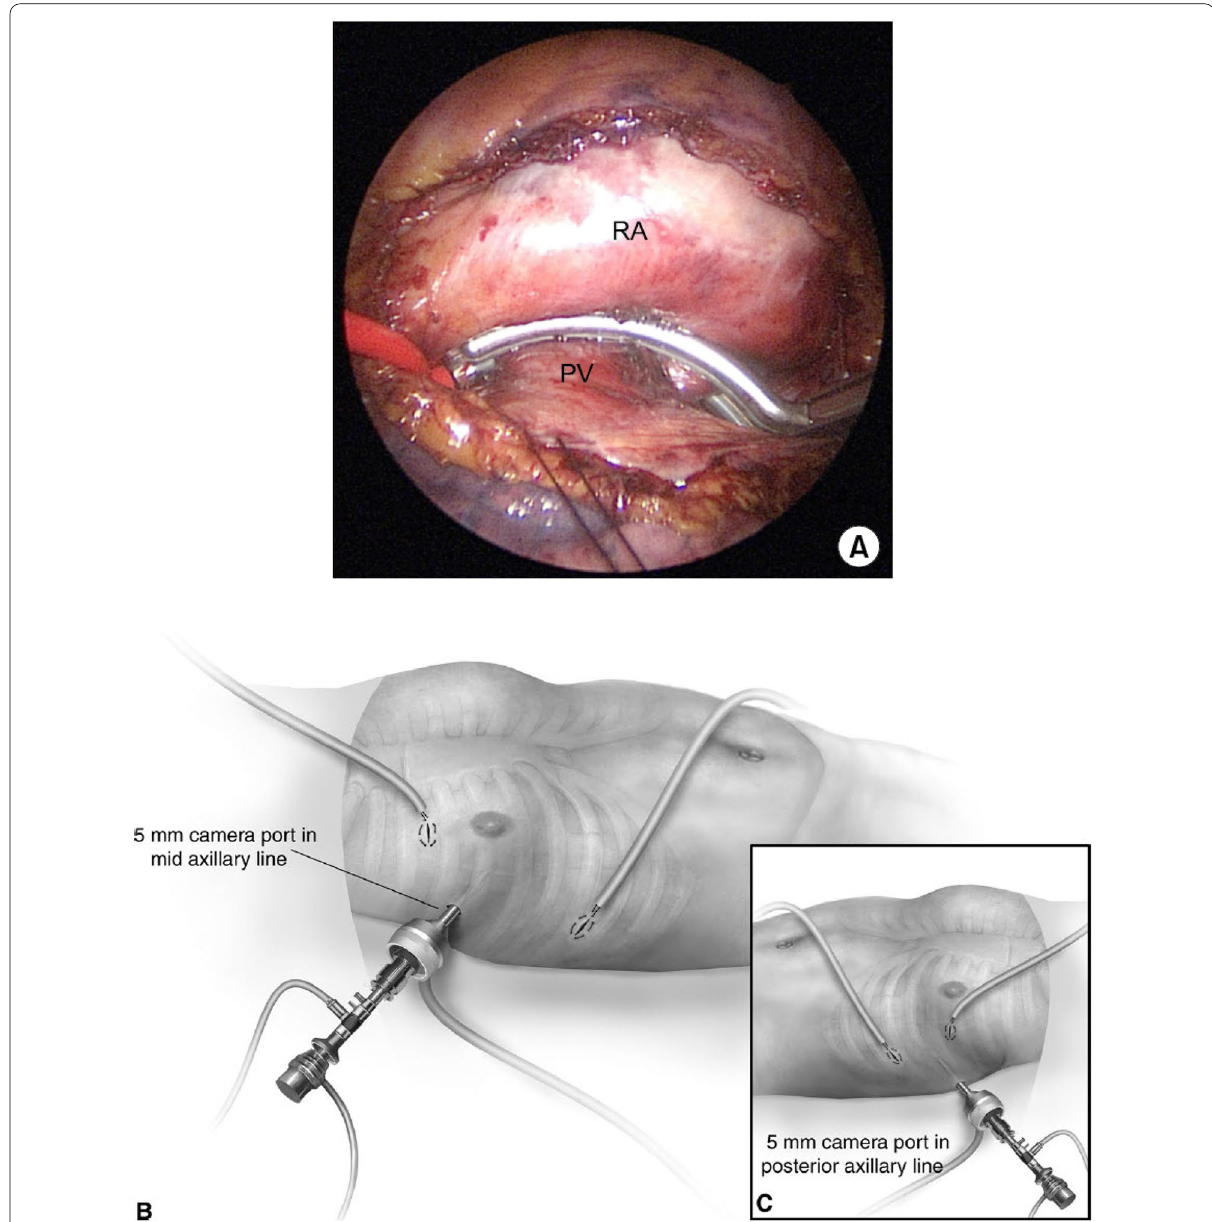
Fig. 1 a Thoracoscopic view of totally thoracoscopic ablation of atrial fibrillation. PV antrum isolation is performed by applying bipolar radiofrequency energy (AtriCure, Inc.). b , c Totally thoracoscopic ablation of atrial fibrillation. This technique is performed via three holes (two